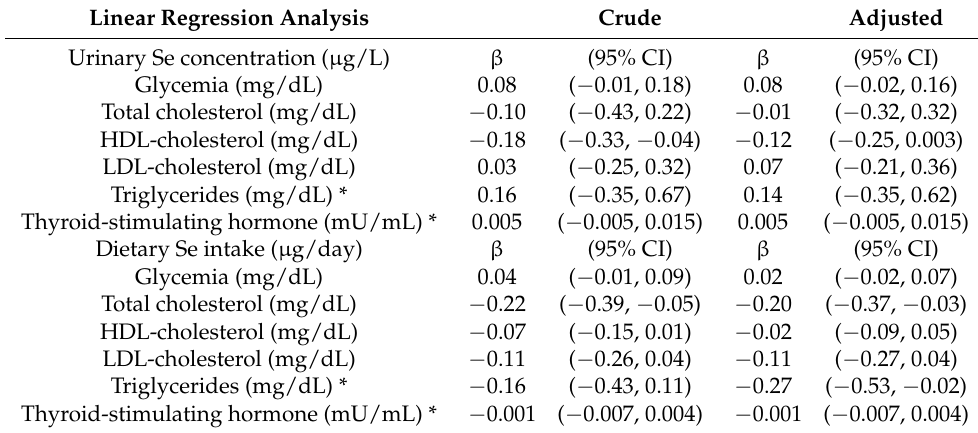
Table 3. Linear regression analysis of glycemia, lipid profile variables and thyroid-stimulating hormone versus urinary selenium (Se) concentration and dietary Se intake biomarkers as independent variables. Crude model and adjusted for age, sex, body mass index (BMI), cotinine levels and alcohol intake along with their 95% confidence interval